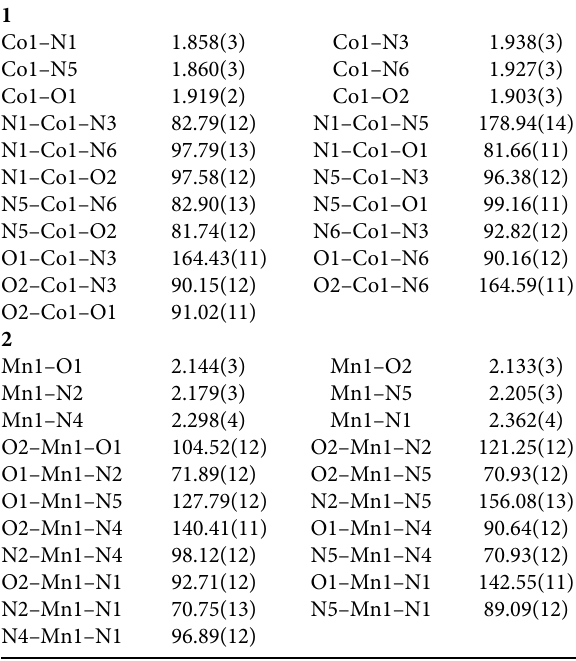
Table 2. Selected bond lengths (Å) and angles (º) for the